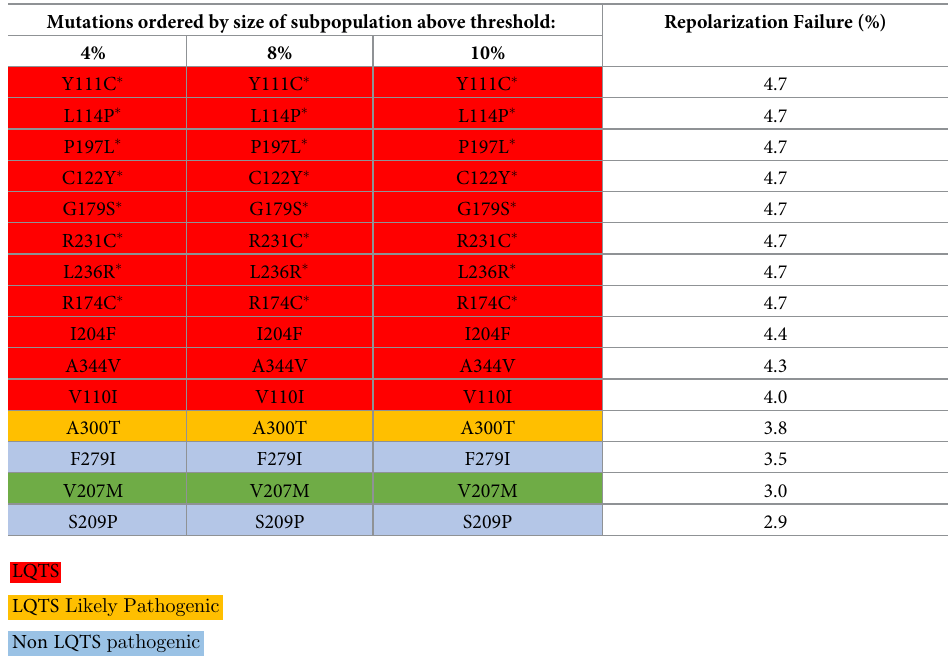
Table 1. Comparison of ClinVar and Computational Results for TS1. Mutations ordered by size of subpopulation above